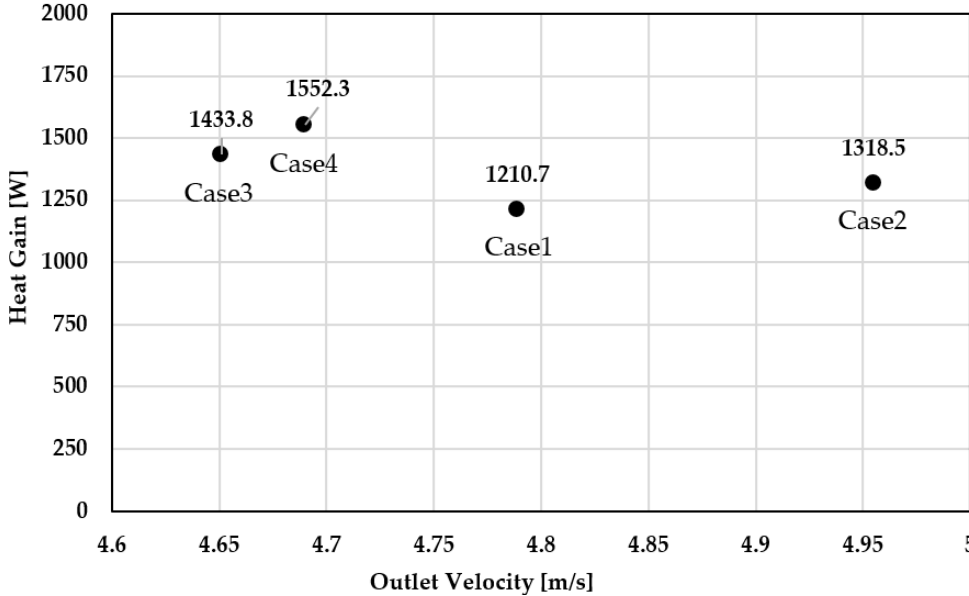
Figure 12. Heat gain according to the outlet velocity.